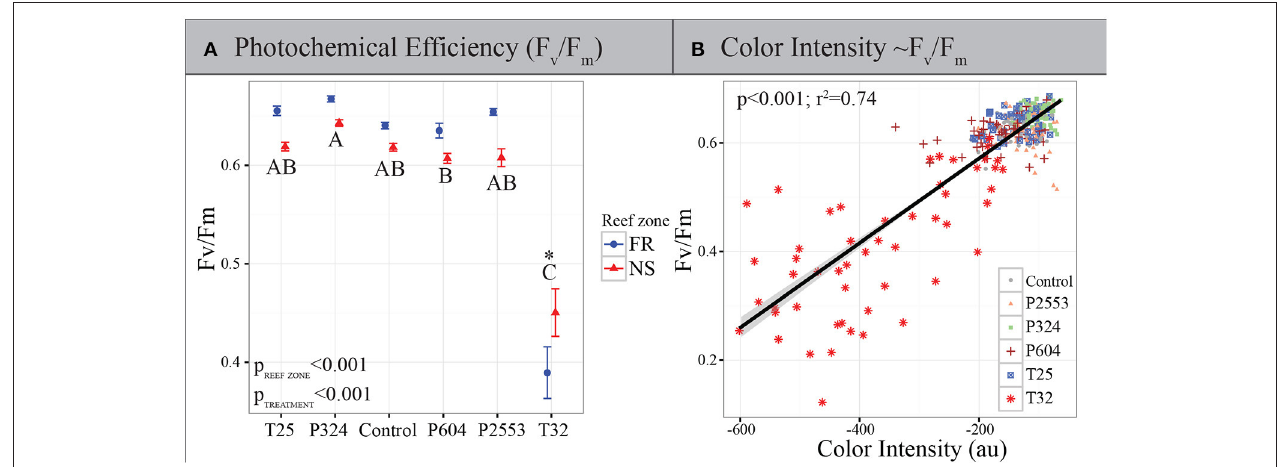
FIGURE 1 | Physiological measurements of in hospite Symbiodinium . (A) Photochemical efficiency of Symbiodinium photosystem II (PSII) (F v /F m ) after 94 days in experimental treatments. Blue circles: forereef population average ( ± SE); red triangles: nearshore population average ( ± SE). Asterisk (*) indicates a significant interaction between treatment and reef zone. Treatment pairs lacking a letter in common indicate a statistically significant difference between those treatments pursuant to Tukey’s Honest Significant Difference tests. High temperatures reduce F v /F m , however, symbionts from nearshore environments remain significantly higher than those from the forereef, while forereef symbionts exhibit higher F v /F m in all other treatments. (B) Maximum F v /F m of Symbiodinium vs. mean coral color intensity after 94 days in experimental treatments (T25 = 25.01 ± 0.14 ◦ C, 515 ± 92 µ atm; Control = 28.16 ± 0.24 ◦ C, 477 ± 83 µ atm; P324 = 28.14 ± 0.27 ◦ C, 324 ±